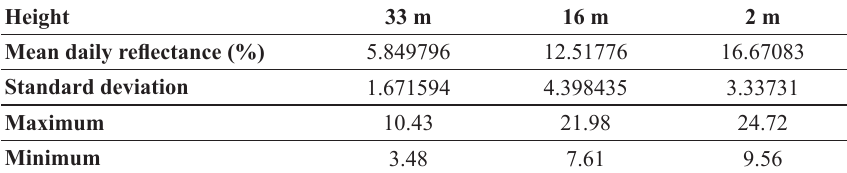
descriptive statistics of reflectance for the dry